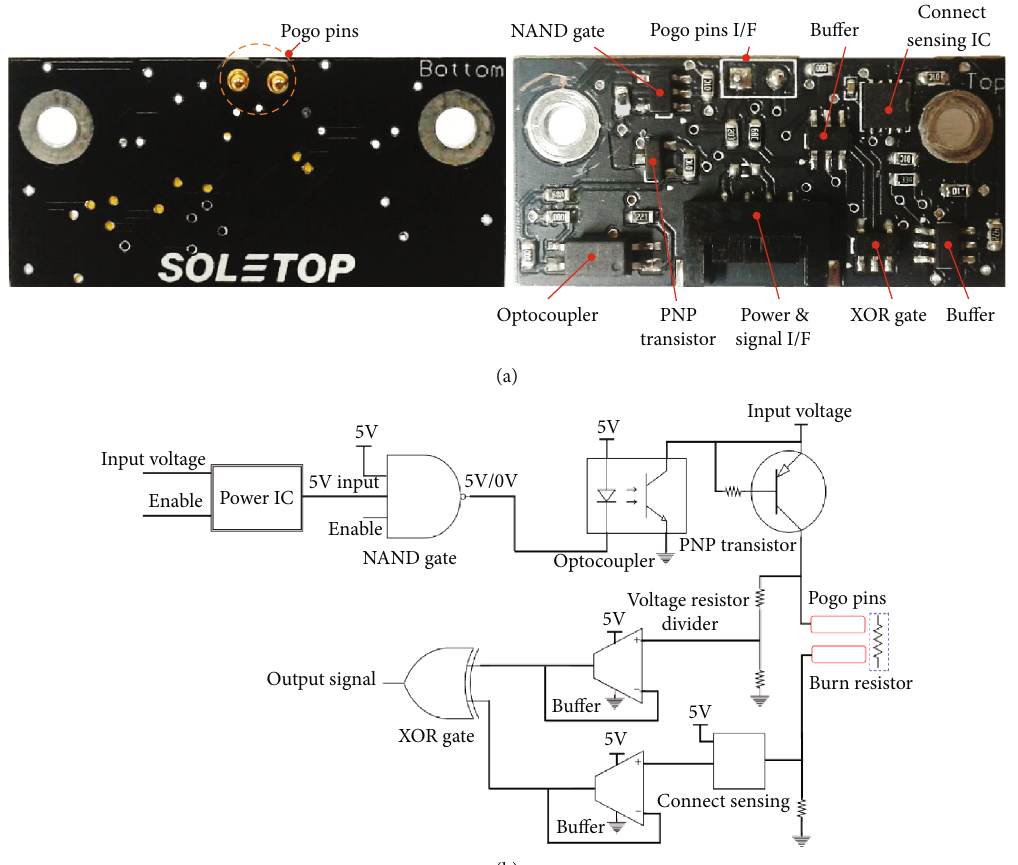
Figure 3: Electrical system of the pogo pin-based mechanism: (a) from and rear views of the electrical interface PCB (dimensions: 34mm × 16mm × 1 mm ) and (b) schematic block